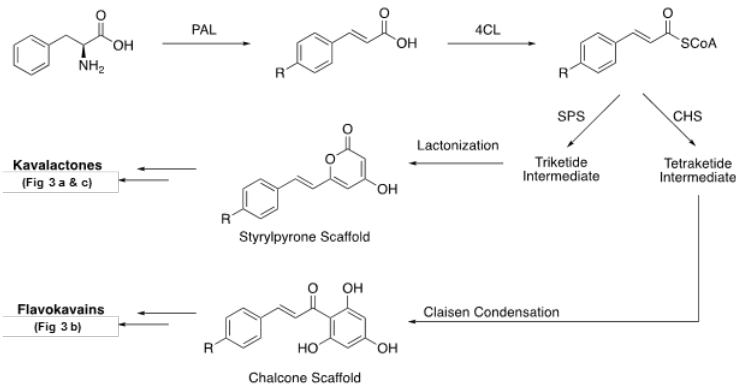
Figure 4. Biosynthetic pathways of kavalactones and flavokavains.